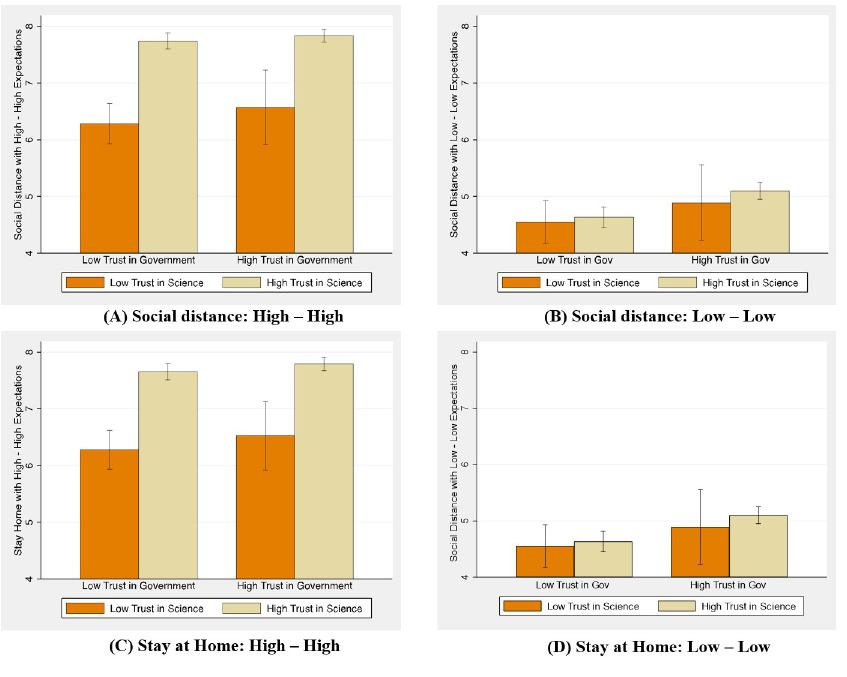
Fig 3. Social distance compliance and